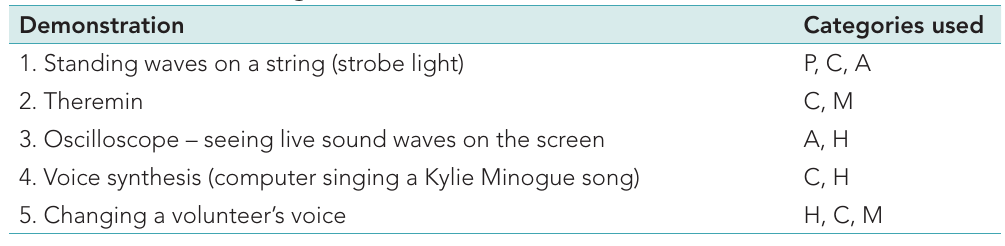
Table 4: ‘Most interesting’ demonstrations from short-term data